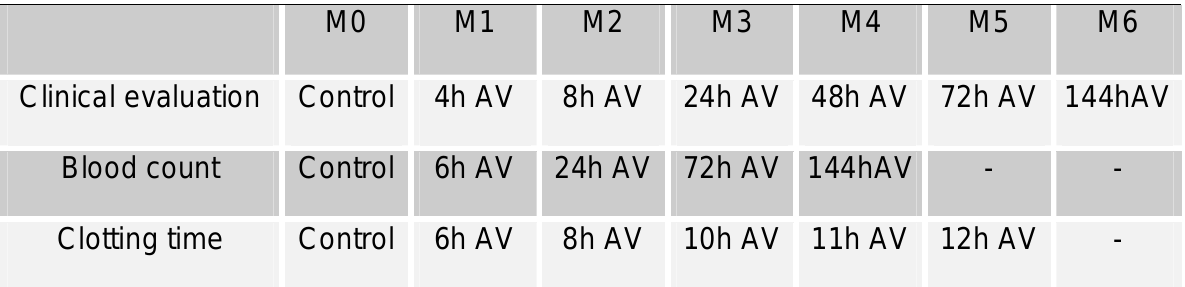
Table 1: Moments of evaluation of the clinical evolution, blood count and clotting time.